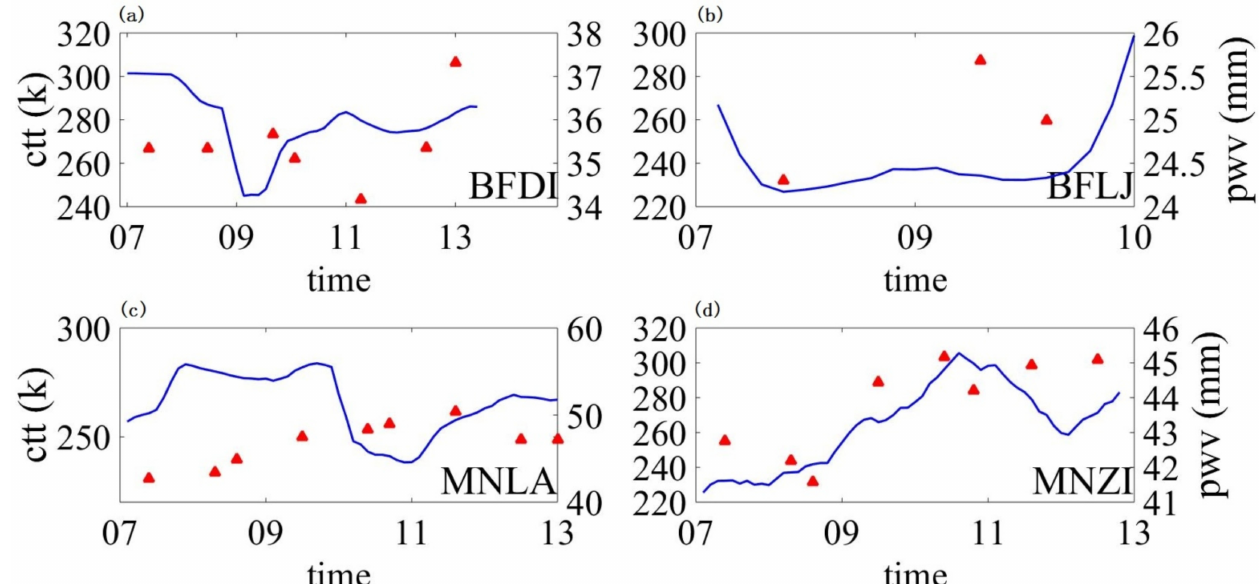
Figure 14. The ctt and the PWV of stations from 07:00 to 13:00 on 24 August 2020 (blue curve: the ctt, unit: k; red scattered points: the PWV, unit mm. ( a ) BFDI, ( b ) BFLJ, ( c ) MNLA, ( d )